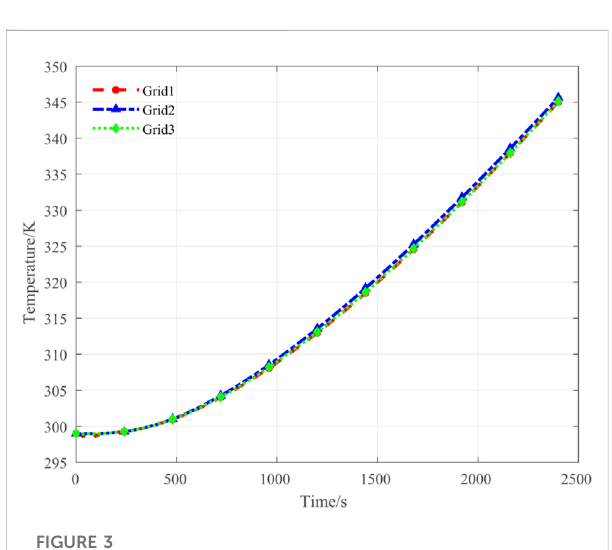
FIGURE 3 Temperature history curves obtained under model discretization schemes with 650,000 (Grid 1), 850,000 (Grid 2), and 1,600,000 (Grid 3) meshing elements for evaluating grid